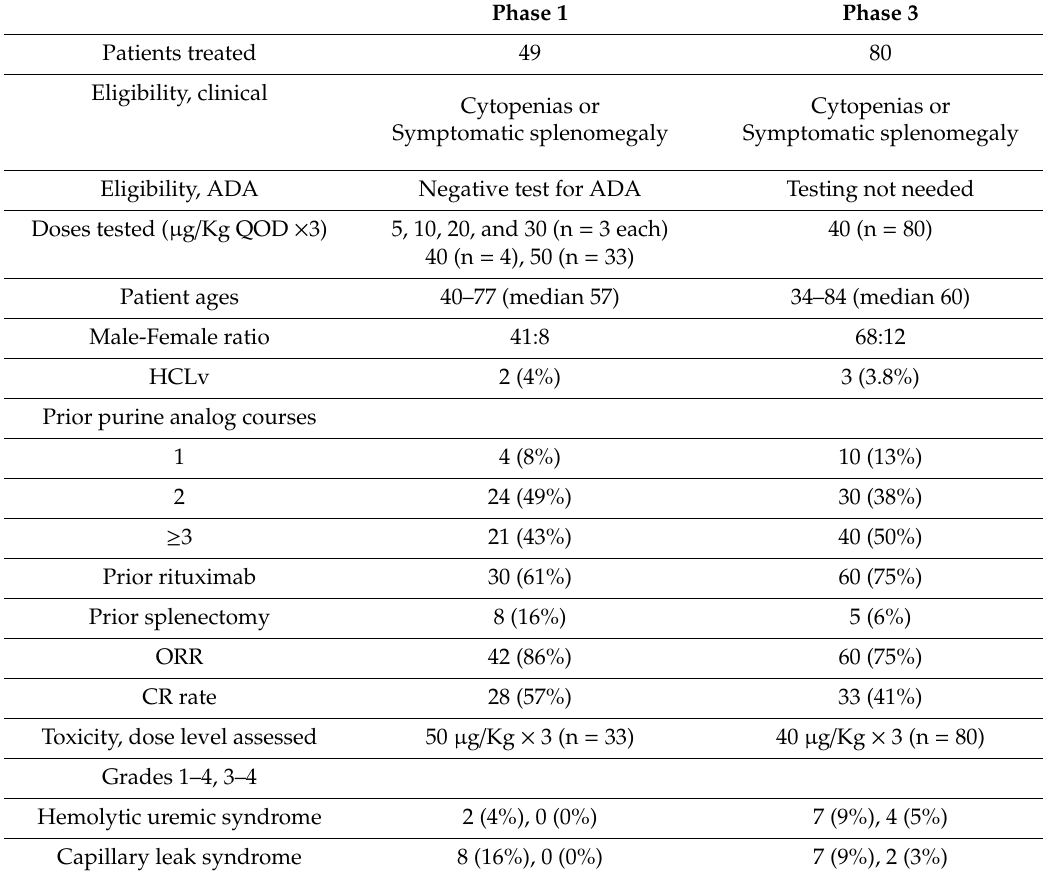
Table 2. Results of moxetumomab pasudotox (Moxe) during phase 1 and 3